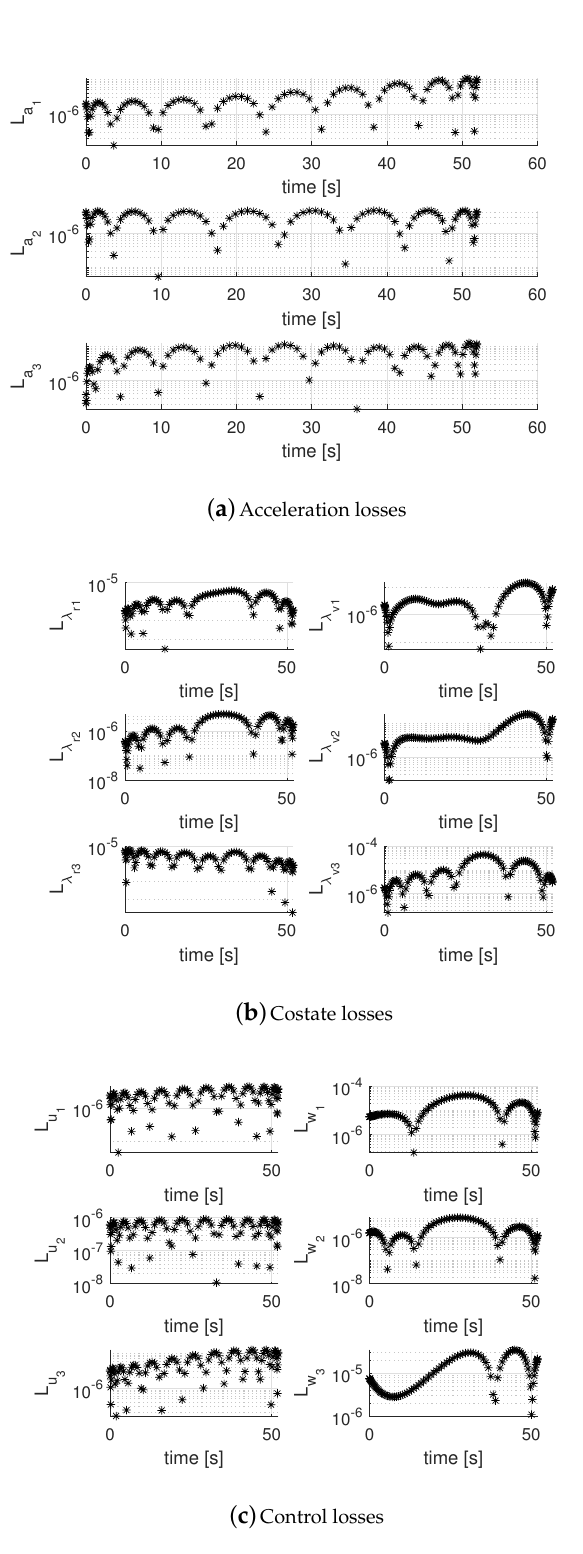
Figure 7. Losses for the constrained intercept problem with penalty Γ = 1 ( N = 100 and L = 16). The optimality of the results is proved by the Hamiltonian loss (namely | H ( t ) + Γ | ), whose mean and final value are 4.95 × 10 − 7 and 1.76 × 10 − 6 , respectively. As can be observed, the PoNN is able to learn the optimal control action, even for this case of bounded control, with a good